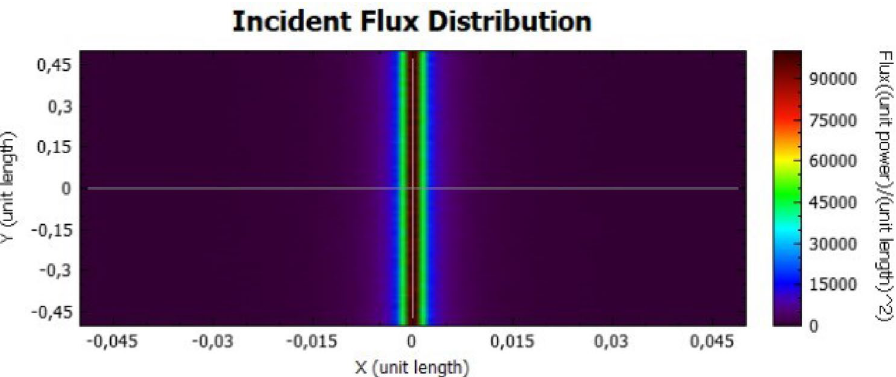
Figure 11. Distribution of incident flux at the receiver from the parabolic concentrator characterised by a reflectivity of